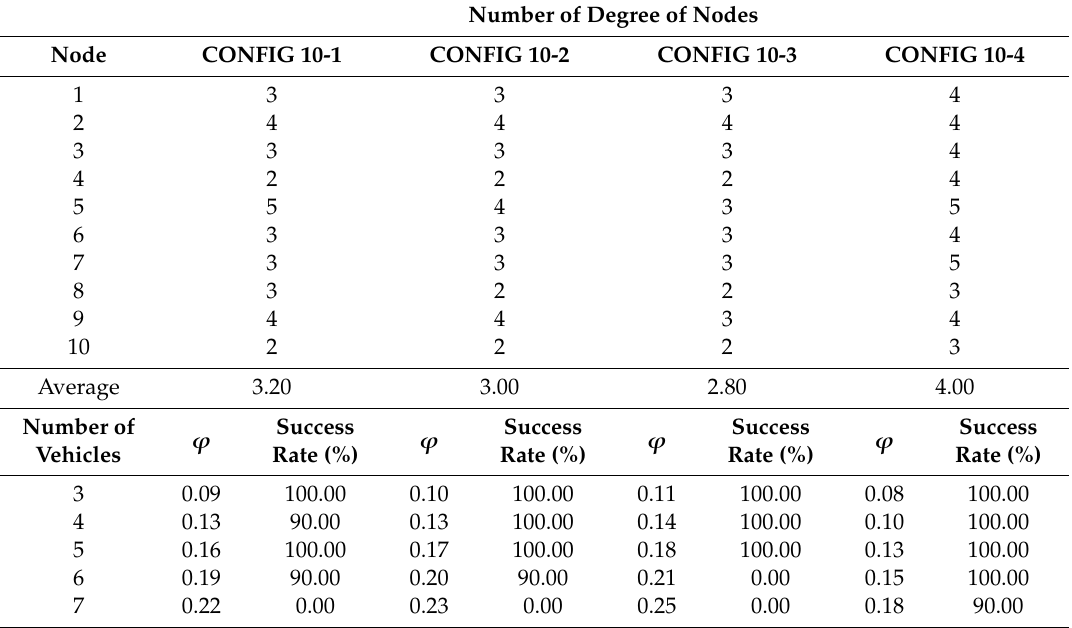
Table 3. Simulation results for 10 nodes.